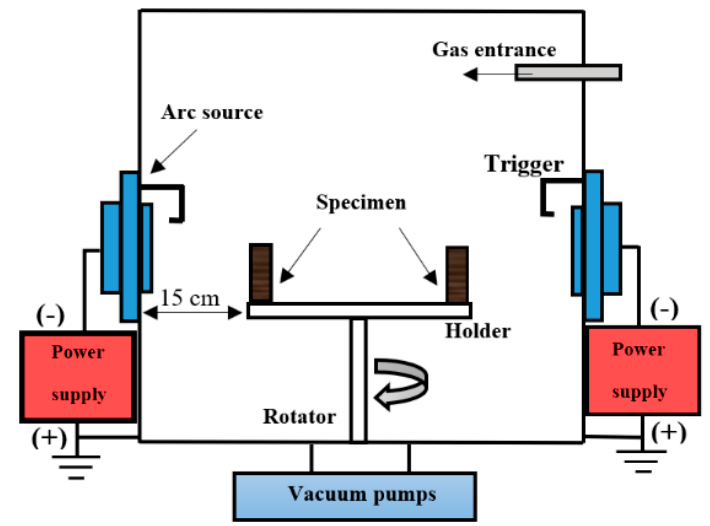
Figure 2. Schematic of the CAE deposition method.